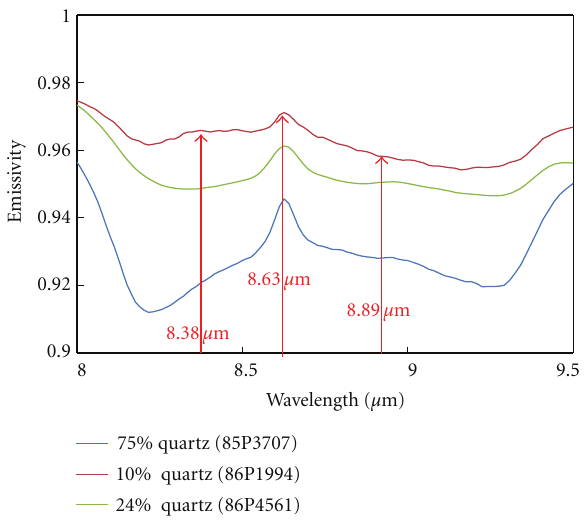
Figure 5: Examples of USDA TIR soil signatures of variable quartz content (XRD analysis of silt-sand fraction) in relation to the diagnostic 8.63 μ m reststrahlen feature.